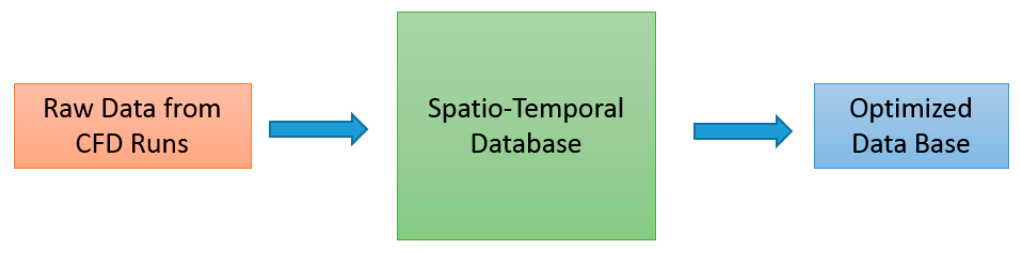
Figure 6. Spatio-temporal database and optimized database.